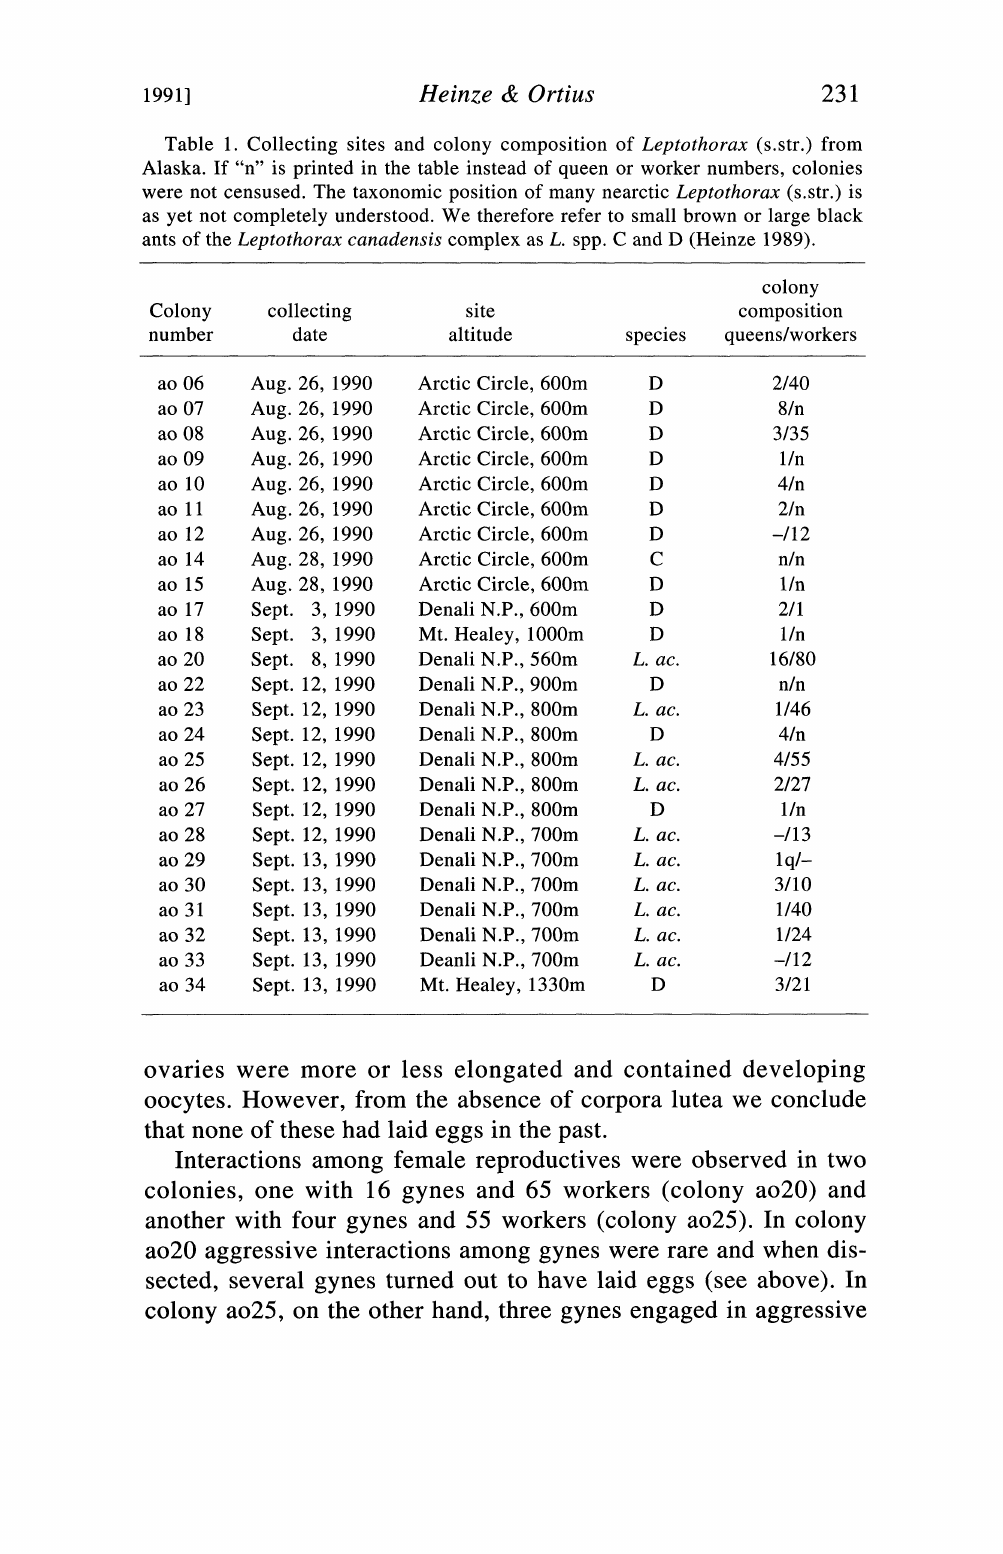
Table 1. Collecting sites and colony composition of Leptothorax (s.str.) from Alaska. If "n" is printed in the table instead of queen or worker numbers, colonies were not censused. The taxonomic position of many nearctic Leptothorax (s.str.) is as yet not completely understood. We therefore refer to small brown or large black ants of the Leptothorax canadensis complex as L. spp. C and D (Heinze